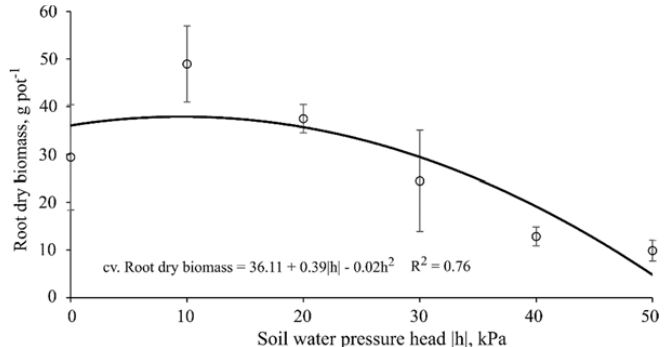
Figure 7. Regression models relating soil water pressure head to root dry biomass of Brachiaria brizantha cultivars for the third cutting period (100 DAE).